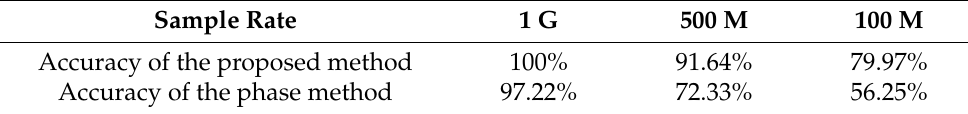
Table 4. Direction-finding accuracy comparation with sample rate